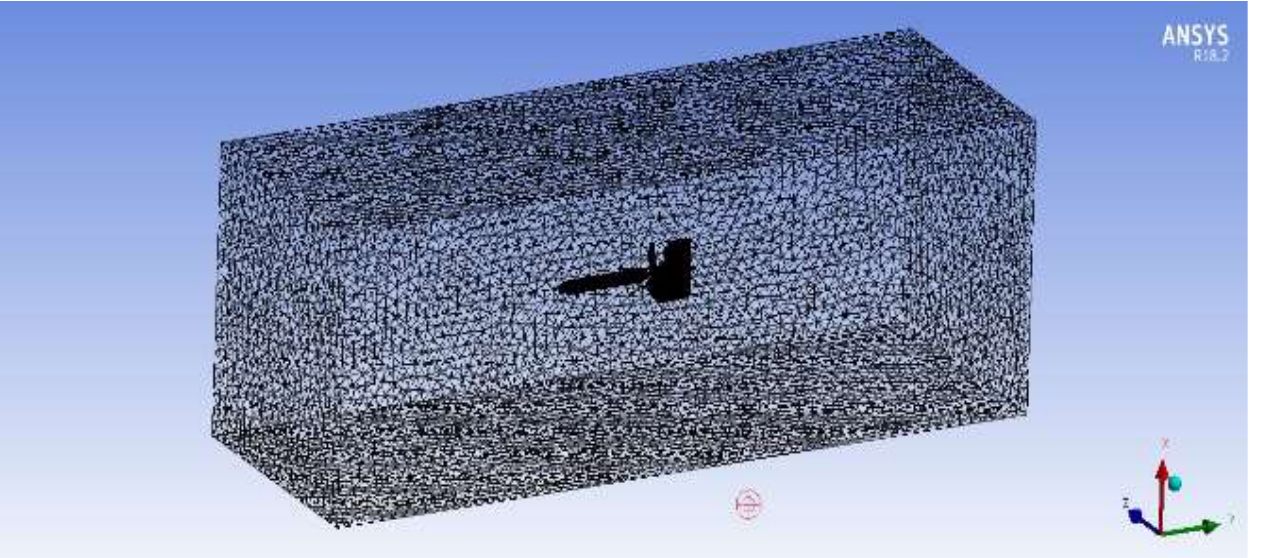
Figure 10. Meshed structure of first model.